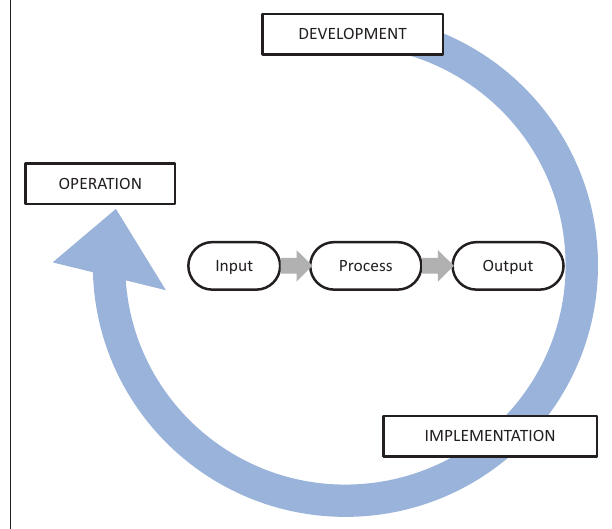
FIGURE 1: Model life cycle and process